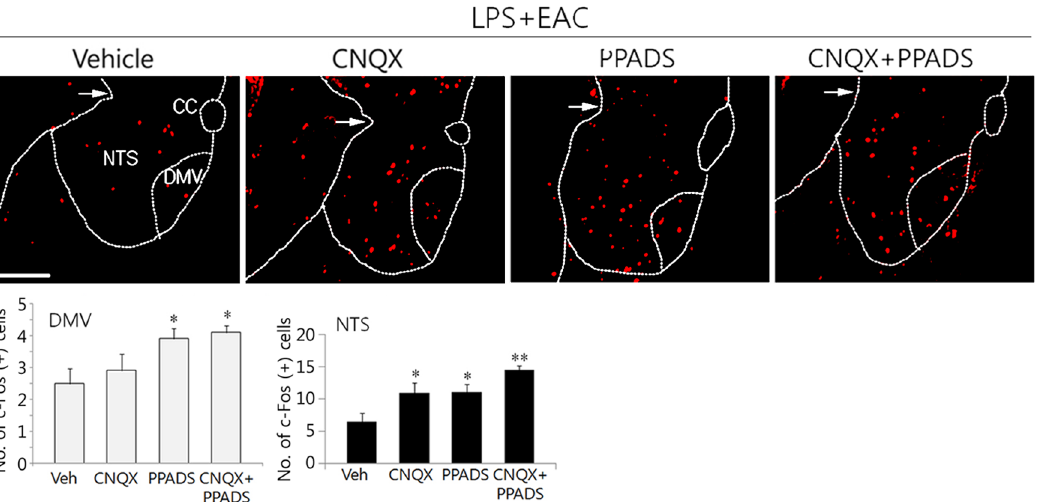
Fig 4. Regulation of c-Fos induction in the DVC by CNQX and PPADS. Following MAC and EAC in combination with focal administration of CNQX and/or PPADS into the DVC area, transverse sections through the caudal portion of the brainstem were subjected to immunofluoresence staining analyses for c-Fos production. Upper images are the representatives showing c-Fos signals in the brain sections and lower graphs show the quantitation of the protein signals in the field. Mean ± SEM (n = 4 independent experiment). * p < 0.05 and ** p < 0.01 vs. vehicle control (one-way ANOVA). The scale bar is 100 μ m.